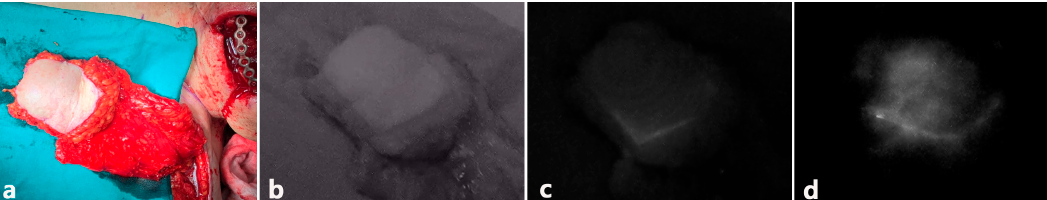
Figure 6. Time difference ICG perfusion of pectoralis major myocutaneous (PMMC) flap. ( a ) Original image of pectoralis major myocutaneous (PMMC) flap, ( b ) before ICG injection, ( c ) 1 min after ICG IV injection, ( d ) 2 min after ICG IV injection.